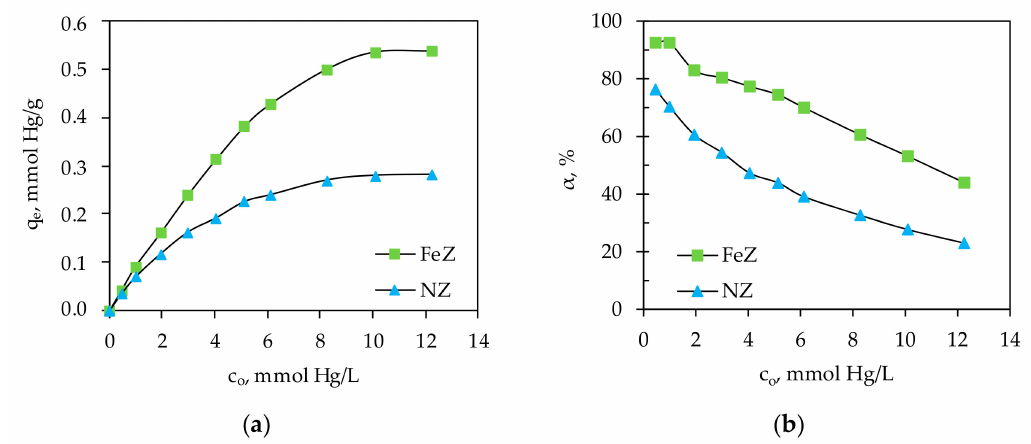
Figure 7. ( a ) The amount of Hg(II) sorbed per gram of NZ and FeZ vs . c o and ( b ) the removal e ffi ciency of Hg(II) vs. c o